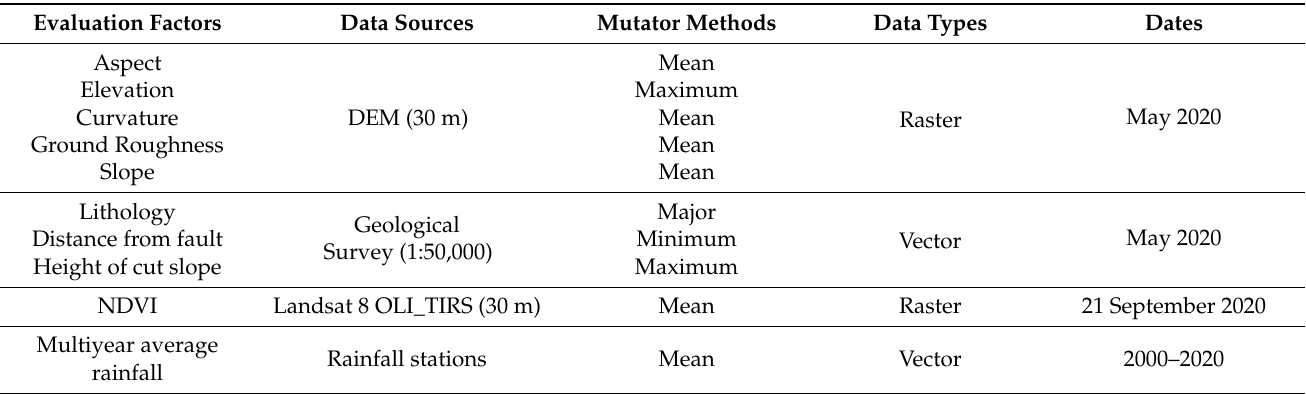
Table 2. Data sources.